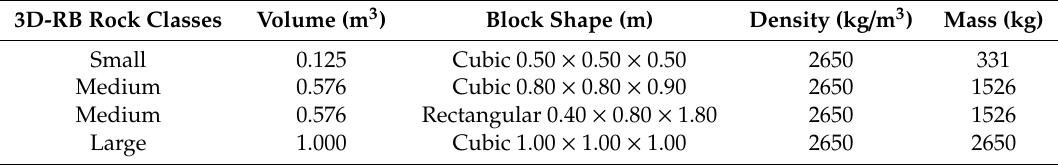
Table 5. Summary of the rock classes defined for the 3D-RB numerical